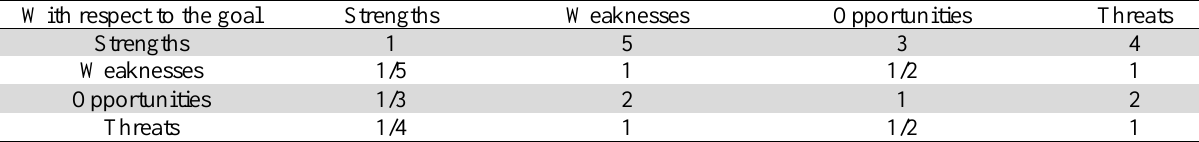
Priorities of SWOT groups (CR= 0.6%) With respect to the goal Strengths Weaknesses Opportunities Strengths